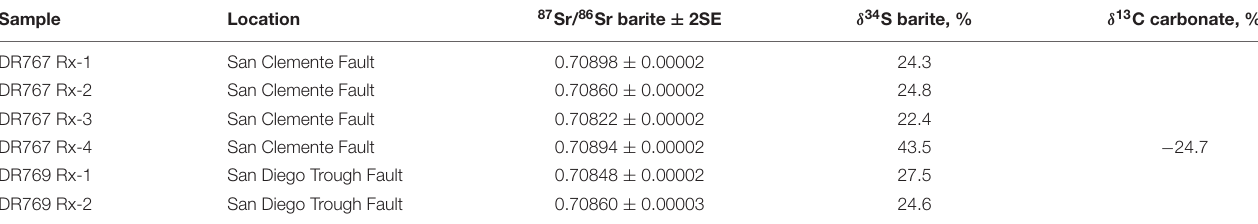
TABLE 1 | Isotopic values.